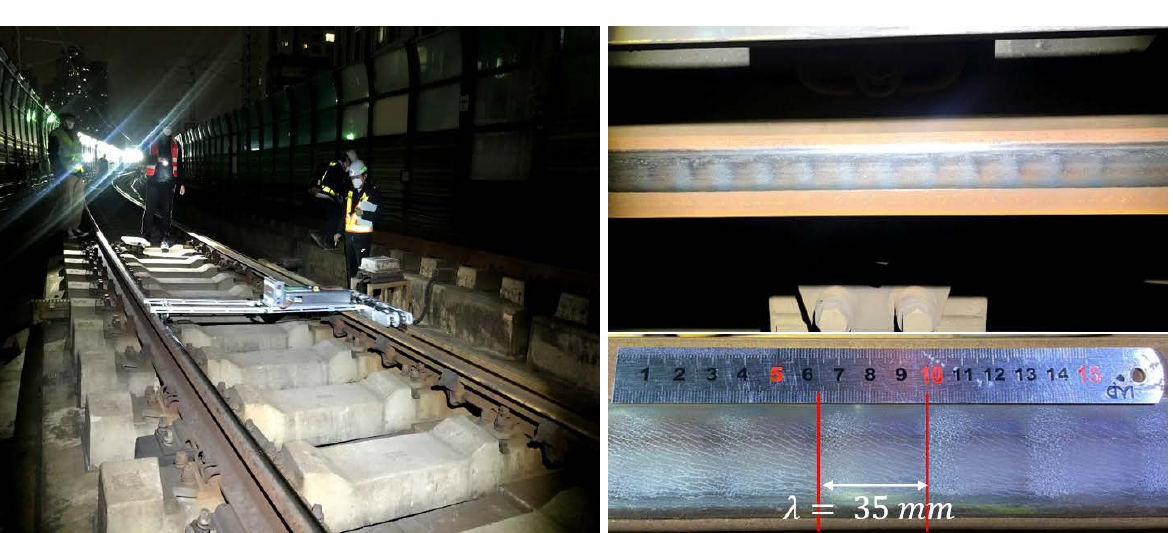
Figure 5. Auto Rail Checker (ARCer) with multiple displacement sensors Although corrugation with a wavelength of 30~35 mm confirmed in Figure 8 appears regardless of the number of sensors used, using one sensor amplified the corrugation section, or the acoustic roughness level value showed a significant difference of at least 10 dB at the λ = 0.314 m wavelength, which was related to wheel diameter. Measure- ments using two sensors were lower than those using three sensors at relatively short wavelength regions.